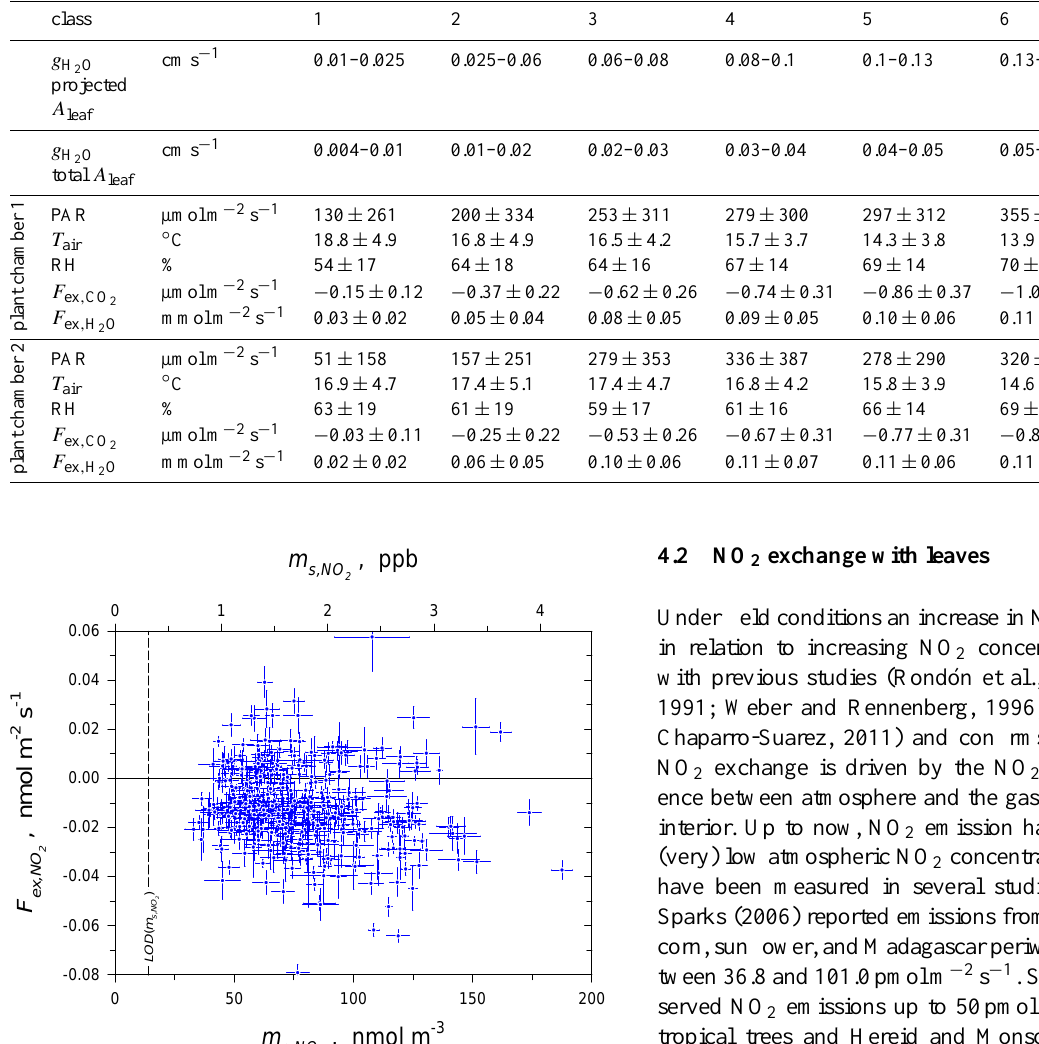
needles did not reach potassium deficiency (Pfl¨uger